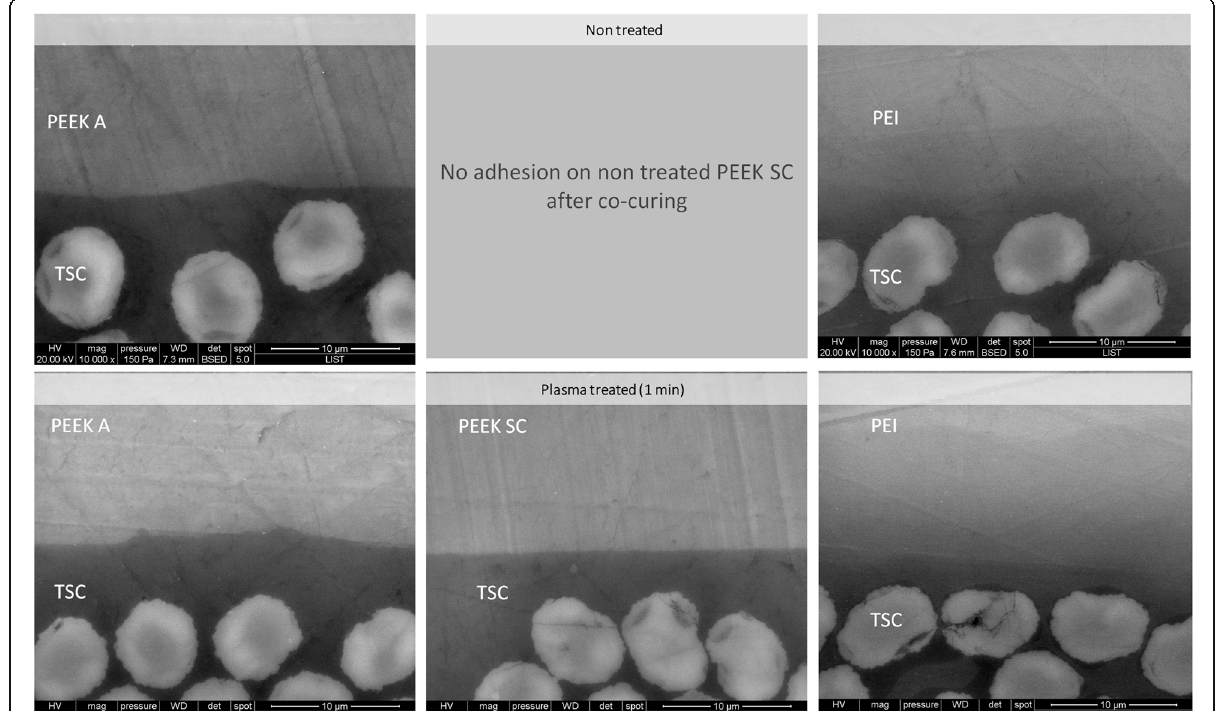
Fig. 12 Cross section view by SEM of the functionalized